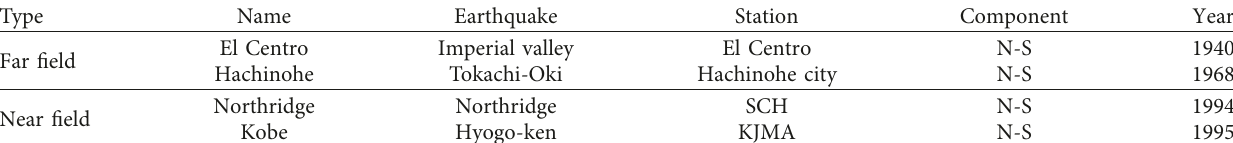
Table 2: Seismic wave information used in the